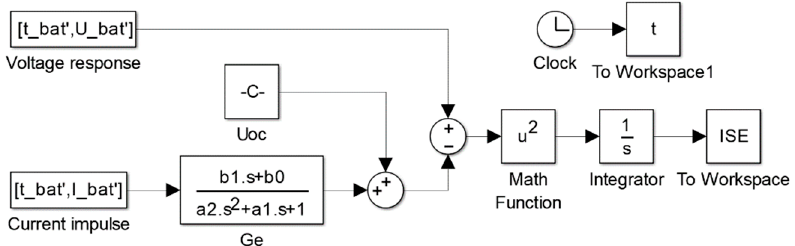
Figure 3. Matlab/Simulink model of the battery voltage for calculating the optimization criterion.